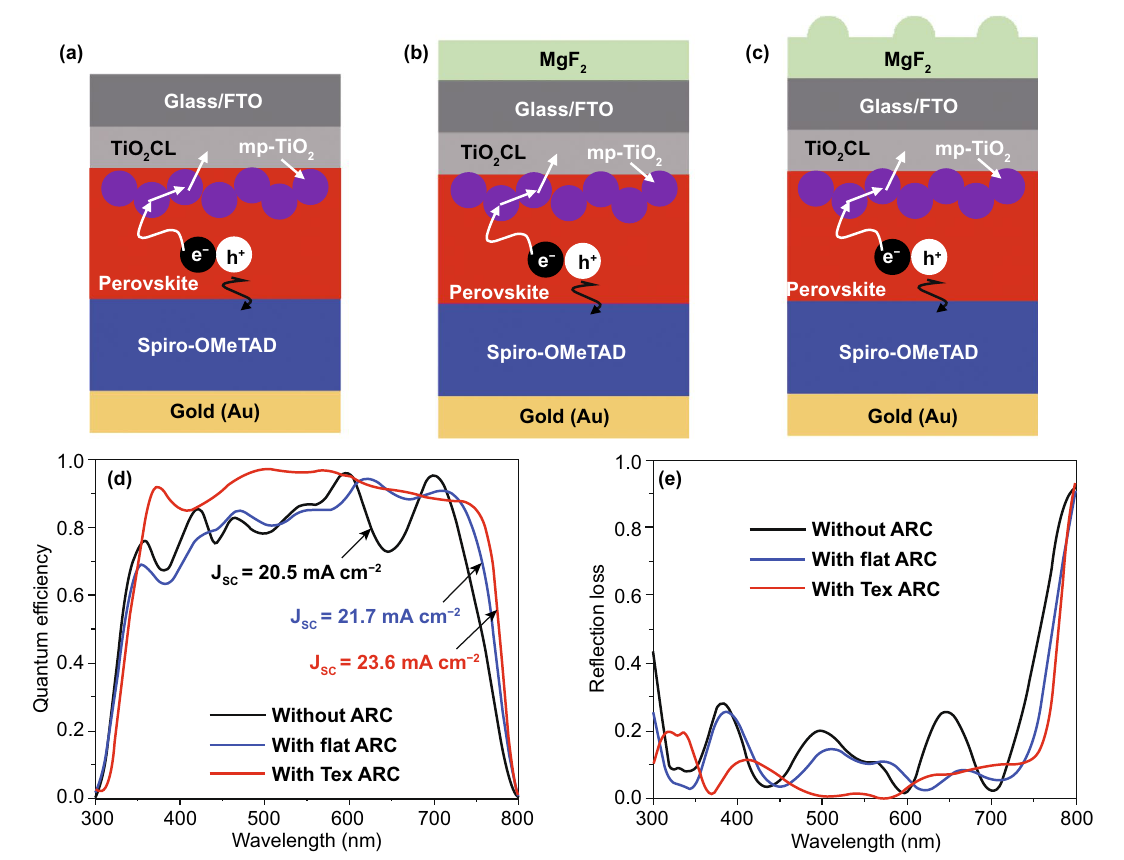
Fig. 5 Schematic diagram of the single‑junction perovskite solar cell (PSC) a without MgF 2 ARC layer, b with a flat MgF 2 ARC layer, and c with a textured MgF